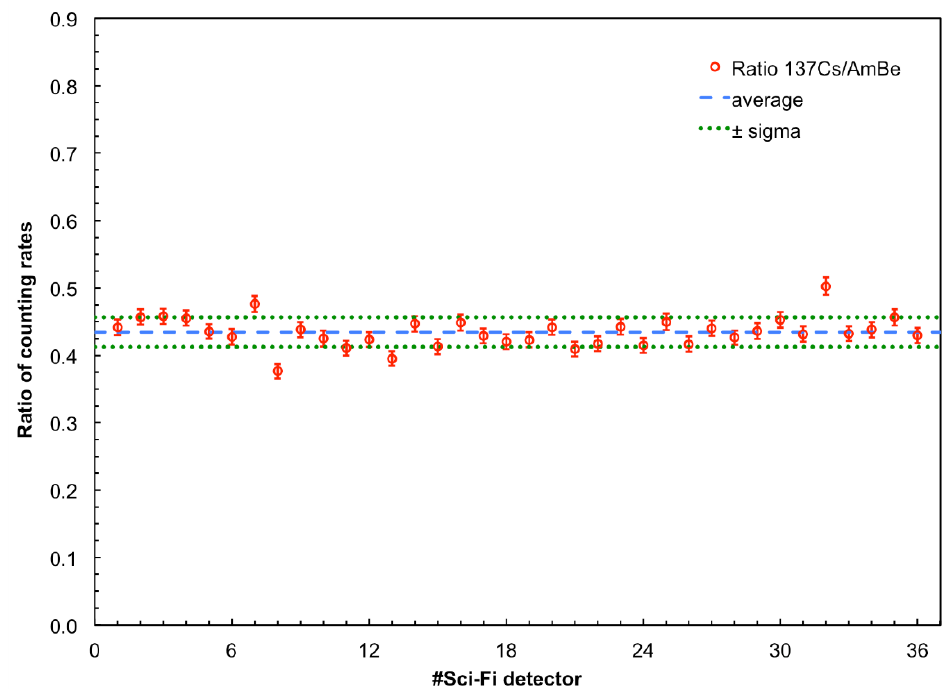
Figure 18. Ratio between the observed counting rates respectively with the 137 Cs and the AmBe sources. The results indicate a reasonably constant behavior. The error bars represent the statistical uncertainty; the blue dashed line is the average ratio; the green dotted lines indicate ± 1 standard deviations from the average.